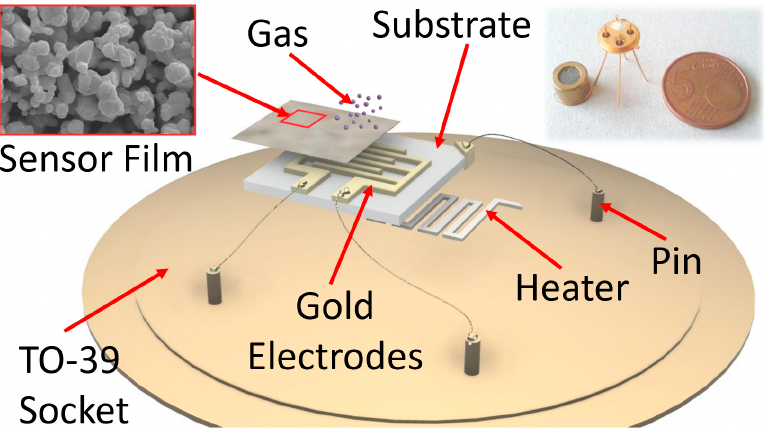
Figure 1. Sketch of a sensor. The film reacting with the gas is screen-printed onto the alumina substrate, endowed with gold comb-shaped electrodes; the heater is placed on the alumina substrate backside. Inset on the left: SEM image of the nanostructured shape of the sensing film material (scale bar is 2 µ m); inset on the right: photo of a real sensor compared with a EUR 5 cent coin.